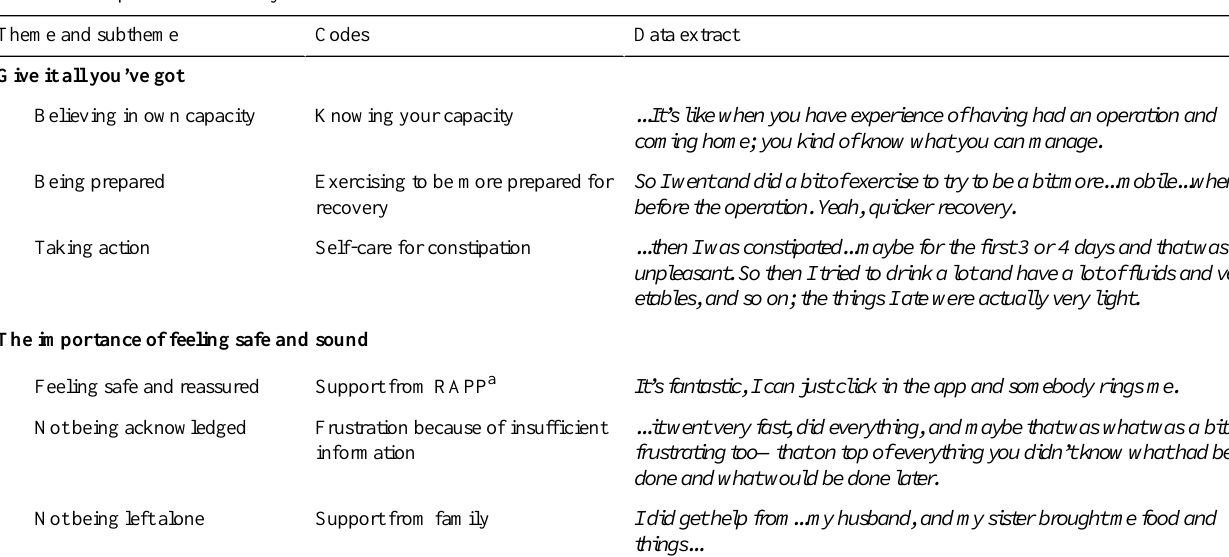
Table 1. Examples from the analysis. Give it all you’ve got